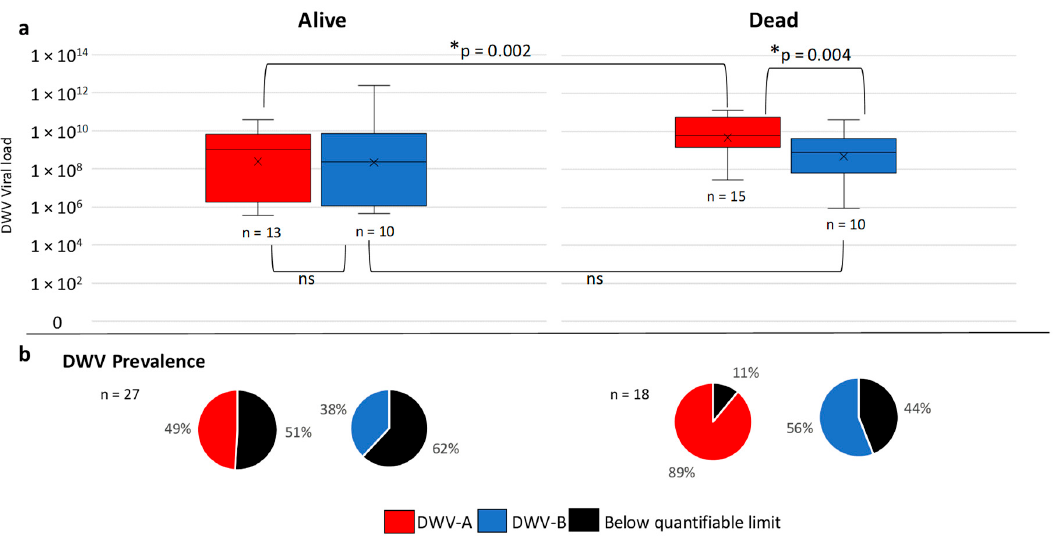
Figure 6. Box plots of viral load for DWV-A and -B in RT-qPCR quantifiable U.S. colonies that survived the overwinter period and those that died ( a ). Significant (*) and non-significant comparisons (ns) are shown. Pie charts show the percentage of DWV quantifiable colonies and those that tested positive below the limit of quantification ( b ).